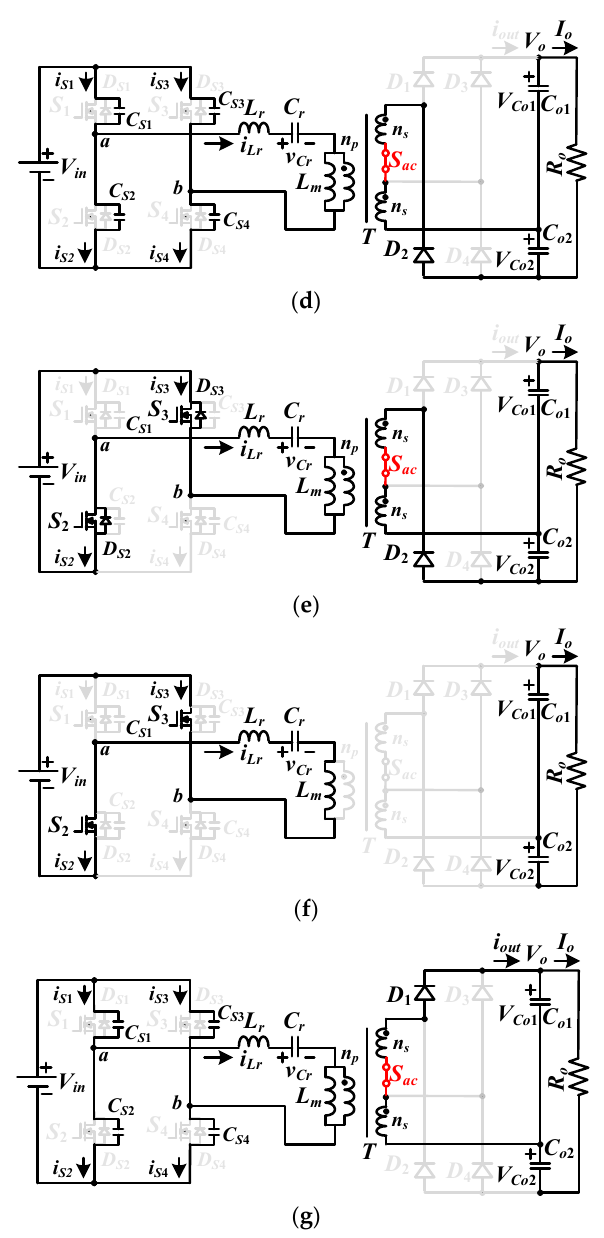
Figure 3. LLC converter at low input voltage region: ( a ) key PWM waveforms; ( b ) state 1 equivalent circuit; ( c ) state 2 equivalent circuit; ( d ) state 3 equivalent circuit; ( e ) state 4 equivalent circuit; ( f ) state 5 equivalent circuit; ( g ) state 6 equivalent circuit.